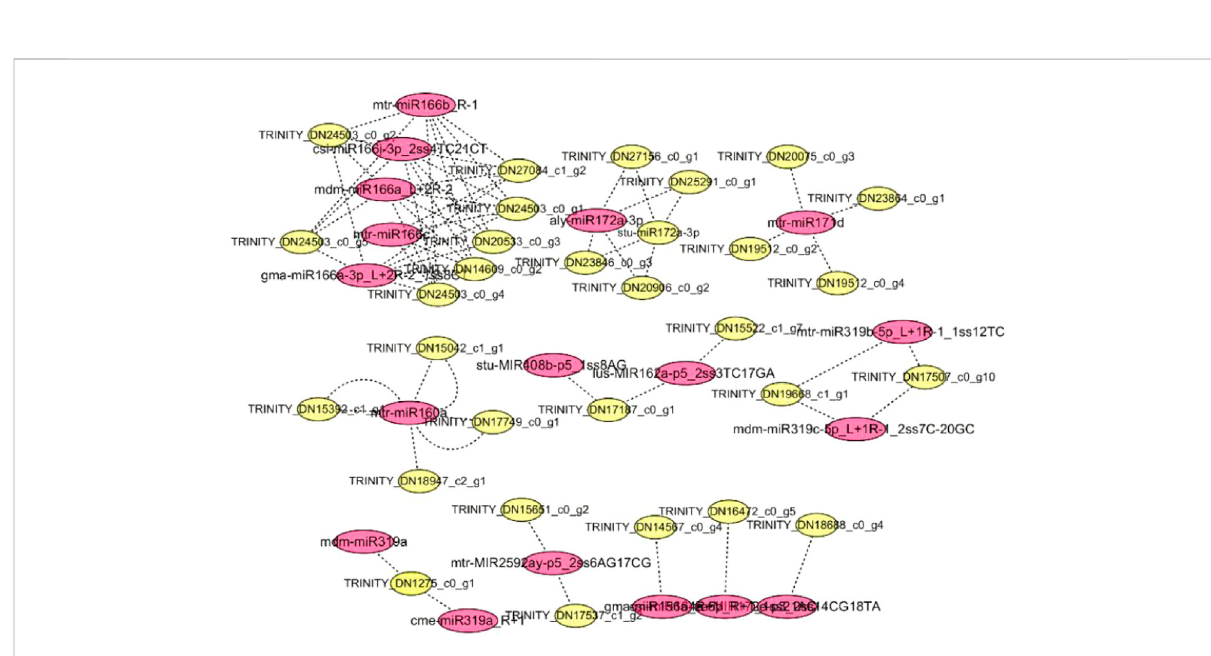
FIGURE 5 Networks of ginsenoside Ro-responsive miRNAs and their targets in ginseng. Red indicates miRNA; yellow indicates